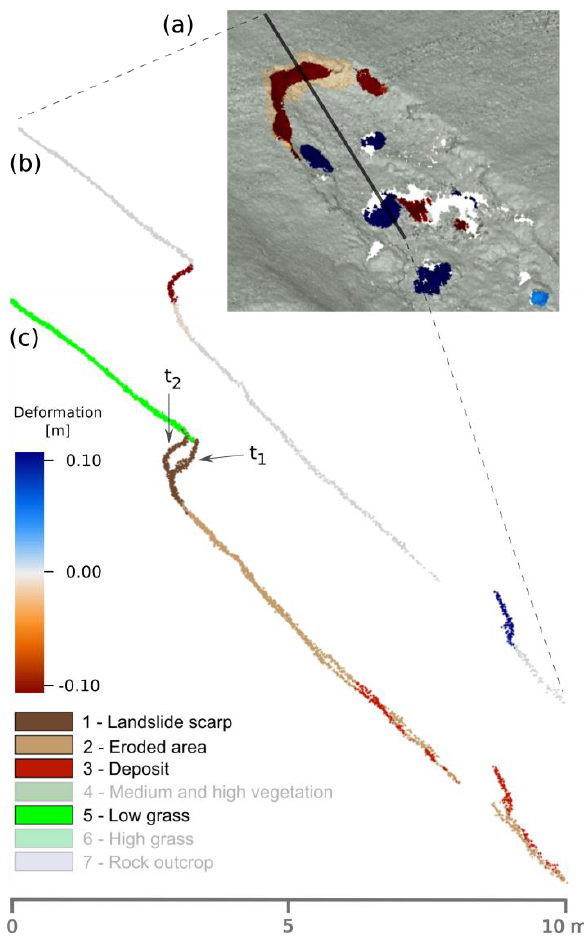
Figure 4. Scarp erosion and deposition of material between epochs t 1 (2011/10/12) and t 2 (2012/05/02). (a) Oblique view of the landslide L1 coloured by mean deformation per object. (b) Transect coloured by mean deformation per object. (c) Transect overlaying the points of both epochs coloured by their class labels (classes irrelevant for the transect are greyed out in the